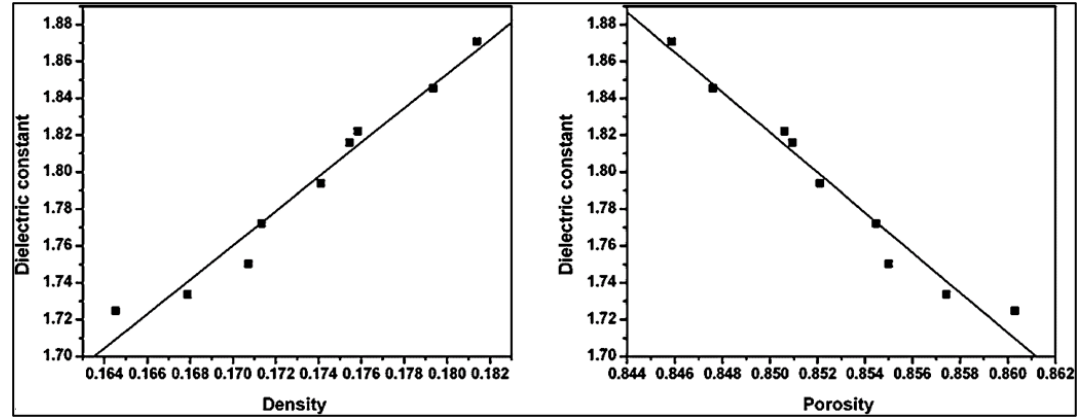
Figure 15. Dependence of density and porosity of PAN nanofiber membranes at frequency of 1 MHz [2]. Khan et al. (2014) reported the dielectric constant of PAN and PMMA as a function of graphene nano flakes as in Figure 17. The physical properties, including the dielectric constant, were significantly increased with graphene concentrations [161].